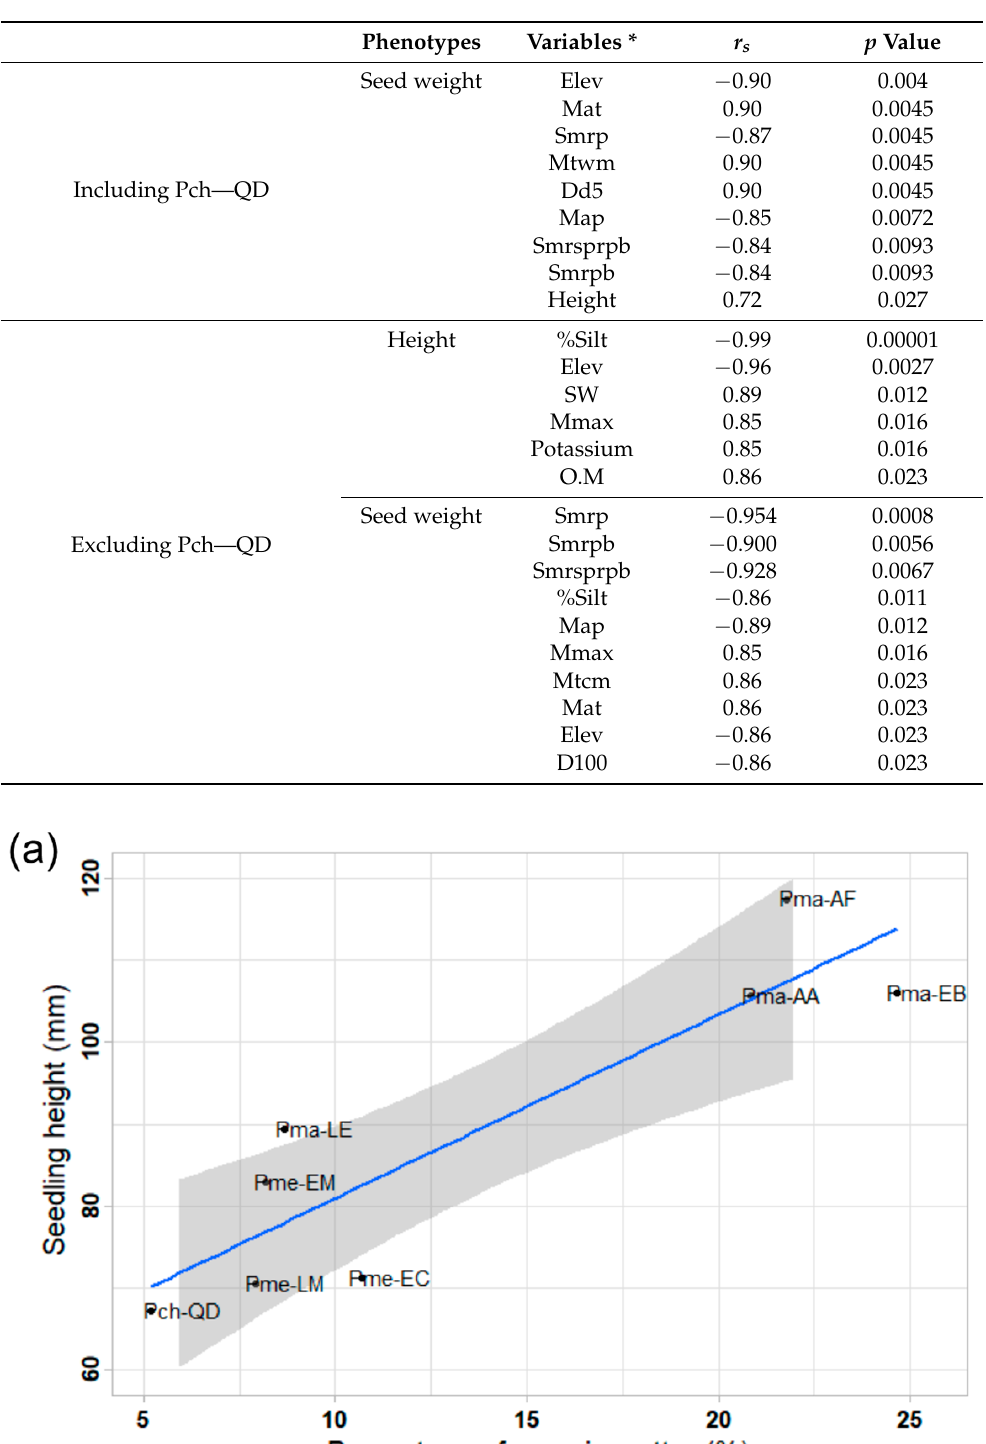
Figure 4. Linear regression models of ( a ) seedling height with percentage of organic ma tt er ( R 2 adj = 0.77, p value = 0.0026, slope parameter ( β ) = 2.24, intercept = 58.54); ( b ) seed weight with mean an-